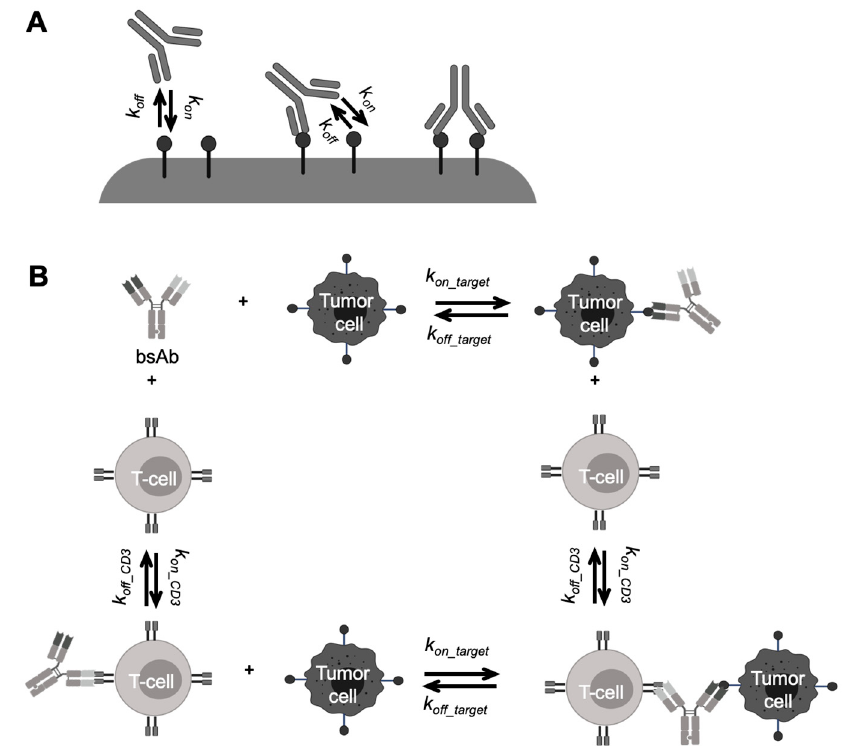
Figure 5. Schematic of antibody-target binding models for bispecific antibodies (bsAbs). ( A ) Schematic of multivalent antibody binding model. The two arms of a bsAb separately bind to targets with the monovalent binding parameters ( k on and k off ). Upon the first binding, the second one while on the cell surface, subject to rate-limiting lateral diffusion within the lifetime of the first engaged antibody-antigen complex (Adapted from abstract graph [77], American Society for Biochemistry and Molecular Biology, 2016). ( B ) A mechanism-based model describing bispecific T-cell engager (BiTE) binding kinetics. The free BiTE binds to a T-cell or a tumor cell independently, forming BiTE-cell dimers. The dimers further bind to either T-cells or tumor cells and form trimmers, which drive the pharmacodynamic effects of BiTEs (Adapted from abstract graph [76], Taylor & Francis, 2018).